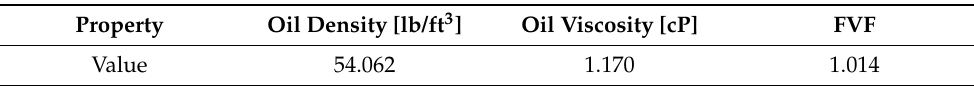
Table 3. PVT data.